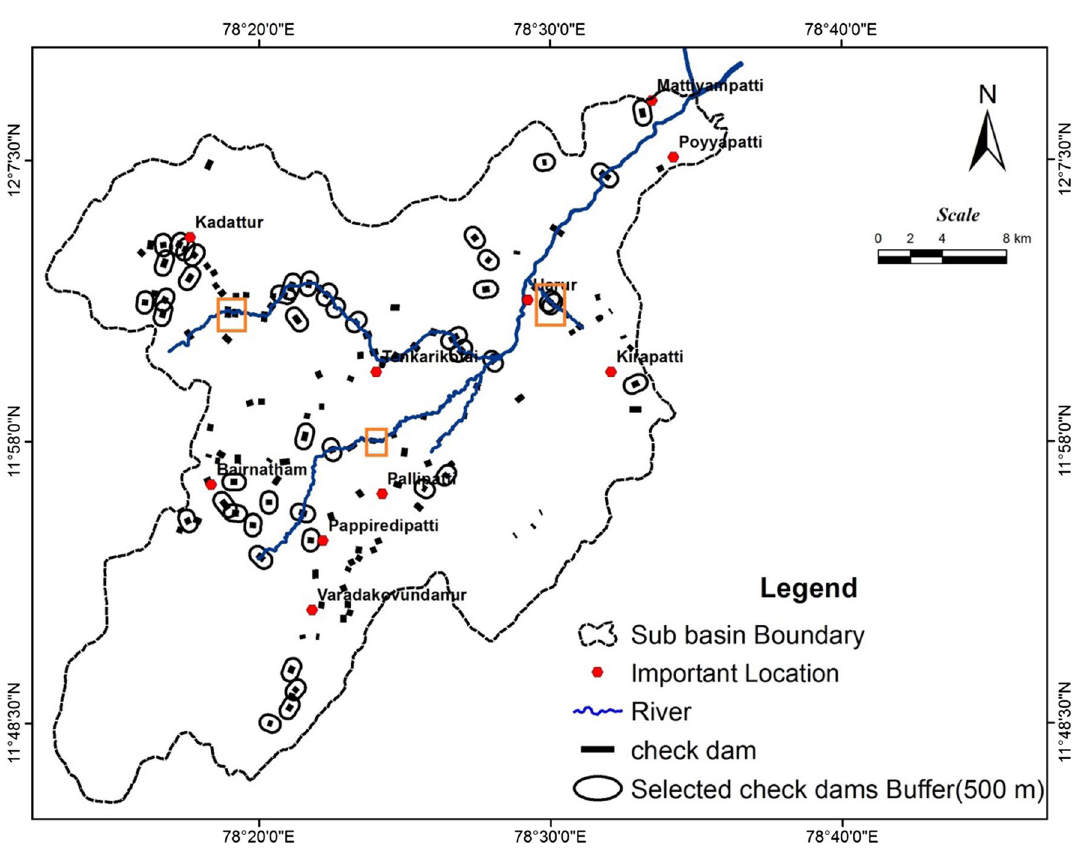
Fig. 15 Decision support model to remove unnecessary check